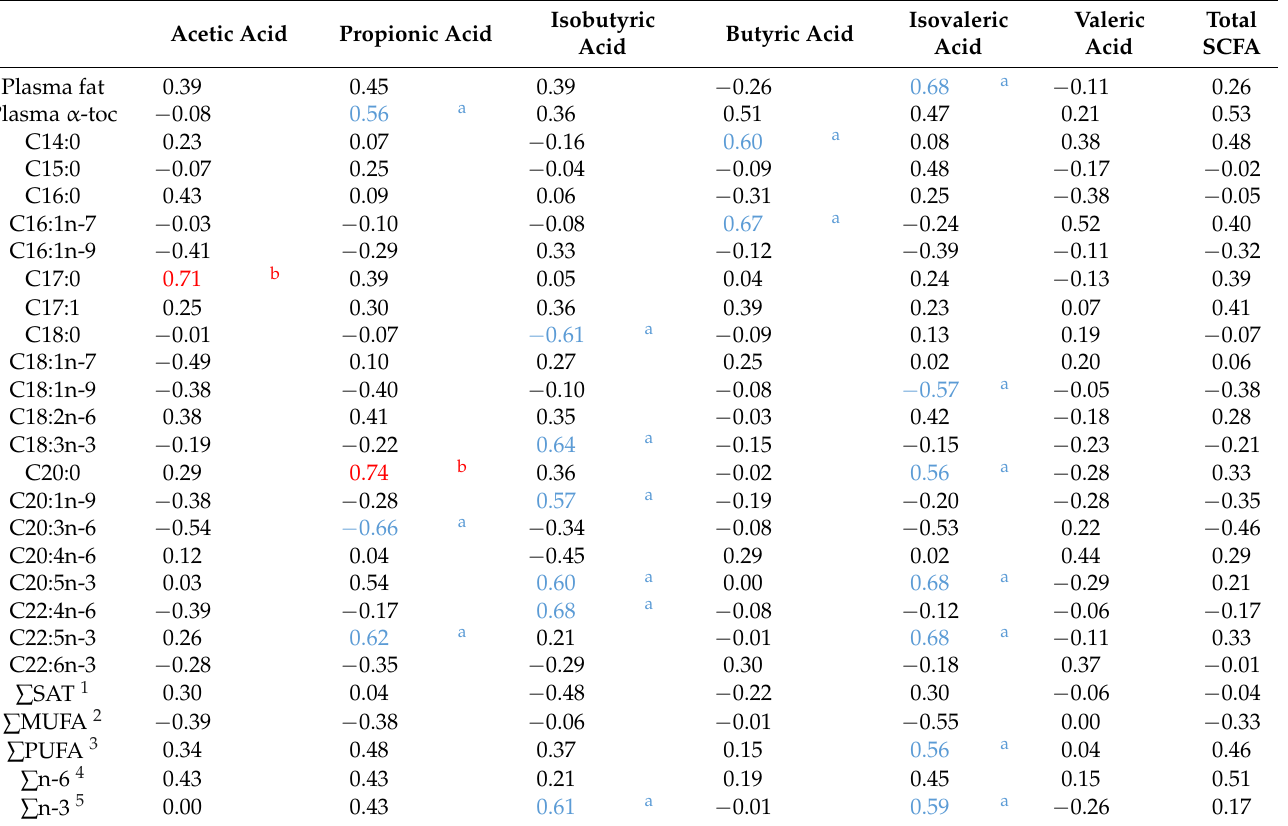
Table 6. Correlation coefficients between short-chain fatty acids (SCFAs) and fatty acid profile in the